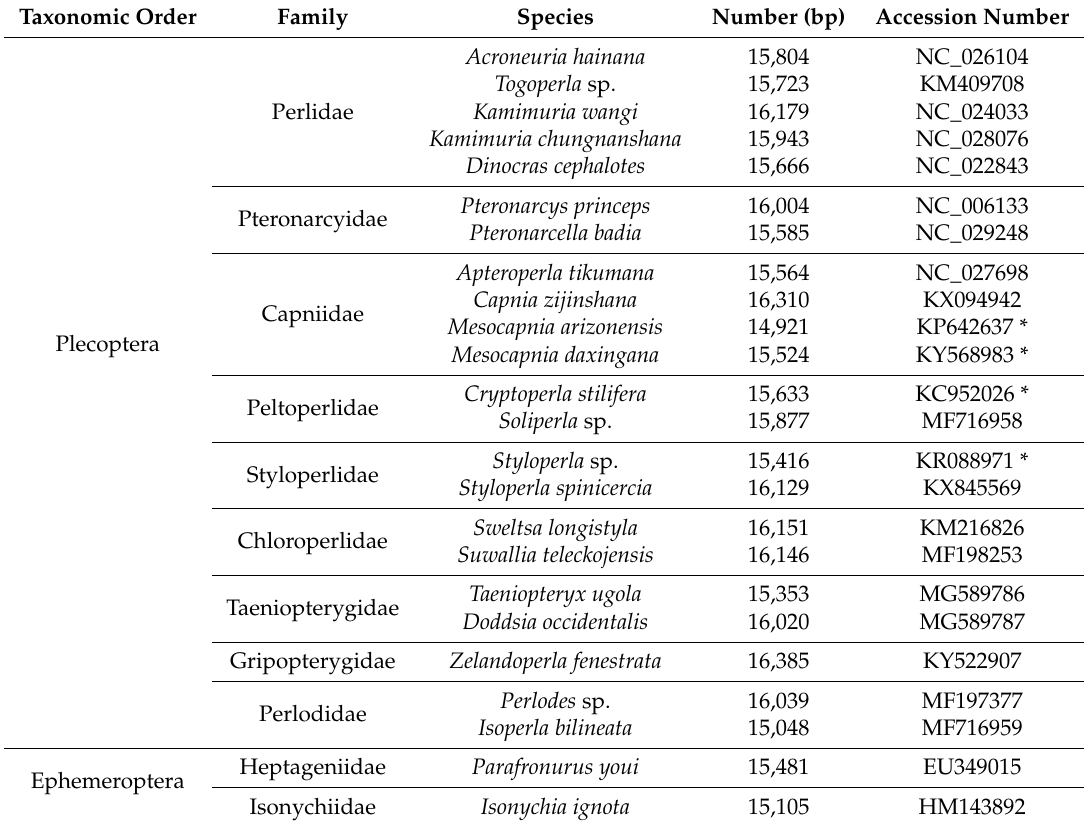
Table 1. General informatics of the taxa used in this study.